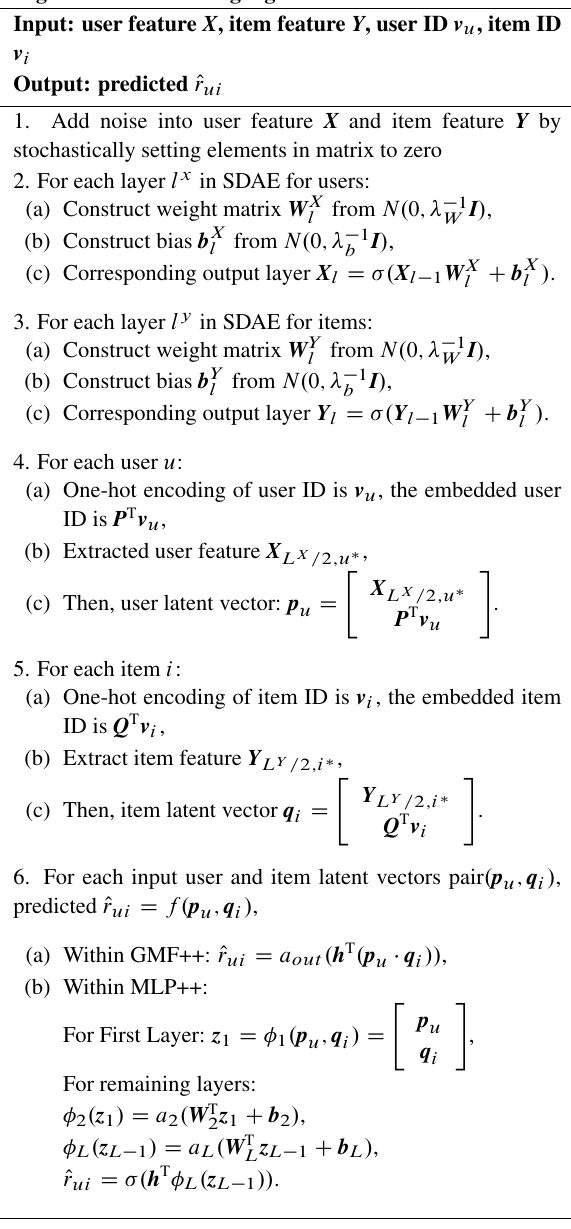
Algorithm 1 Learning algorithm for